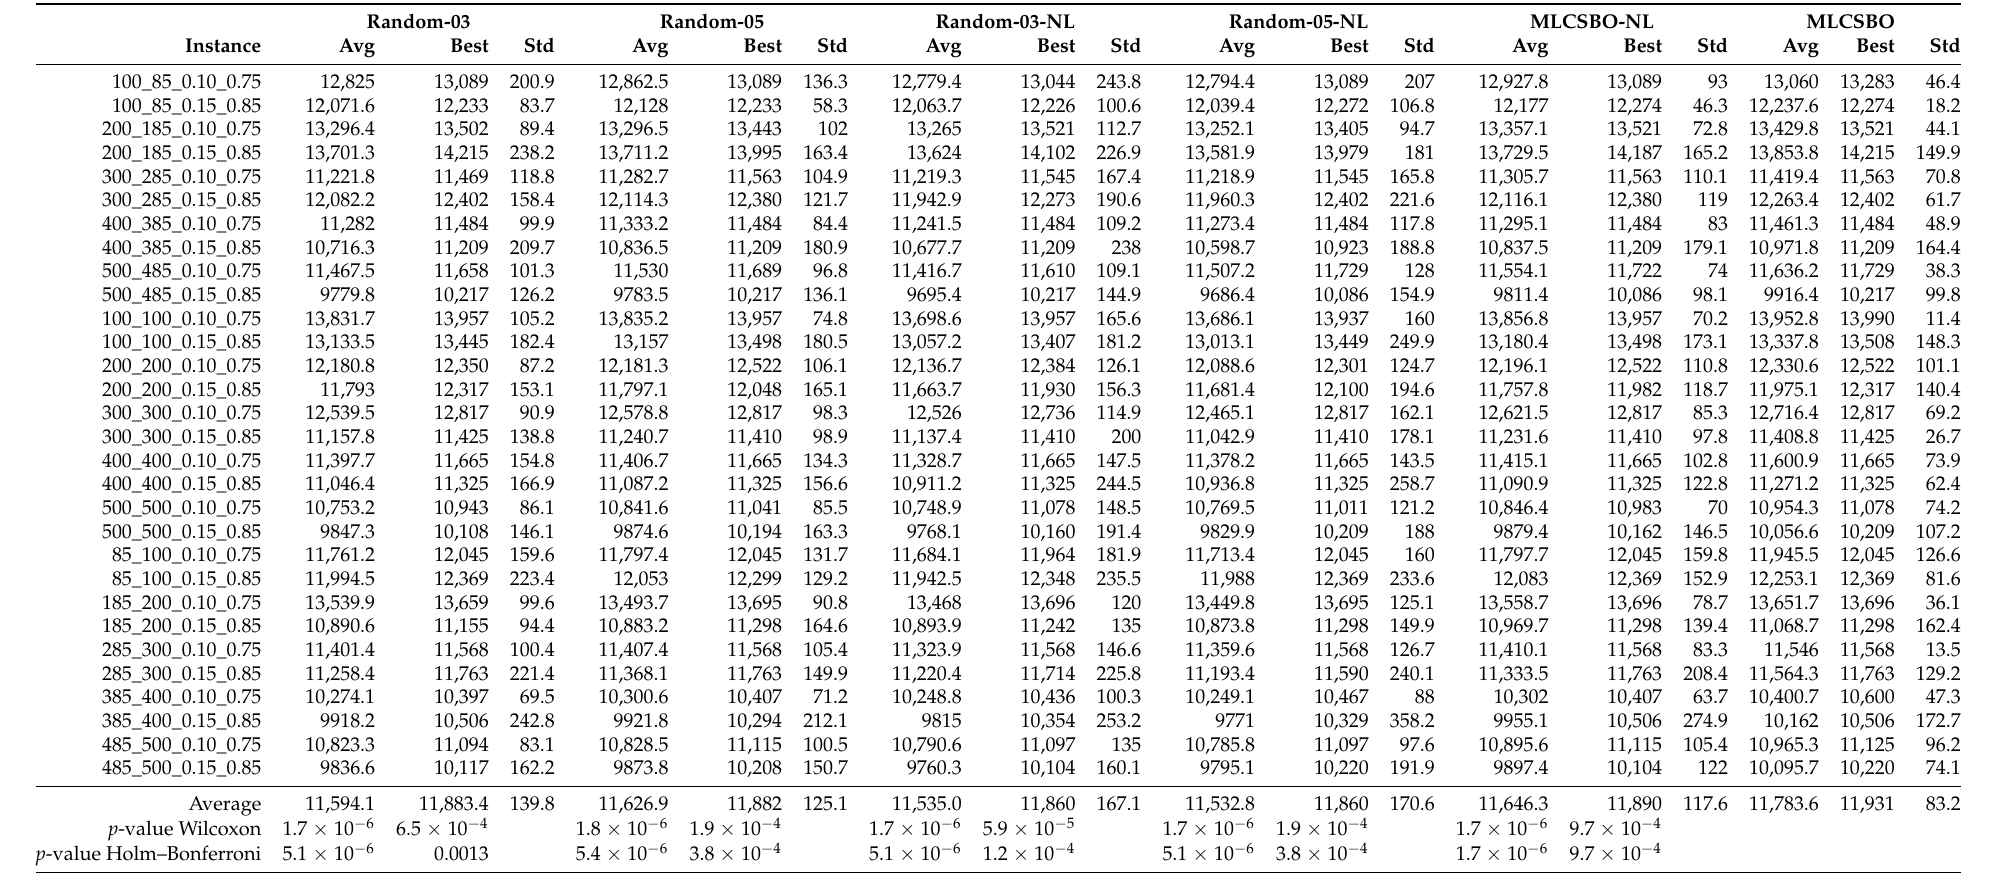
Table 2. Comparison between MLCSBO and random operators, with and without local search